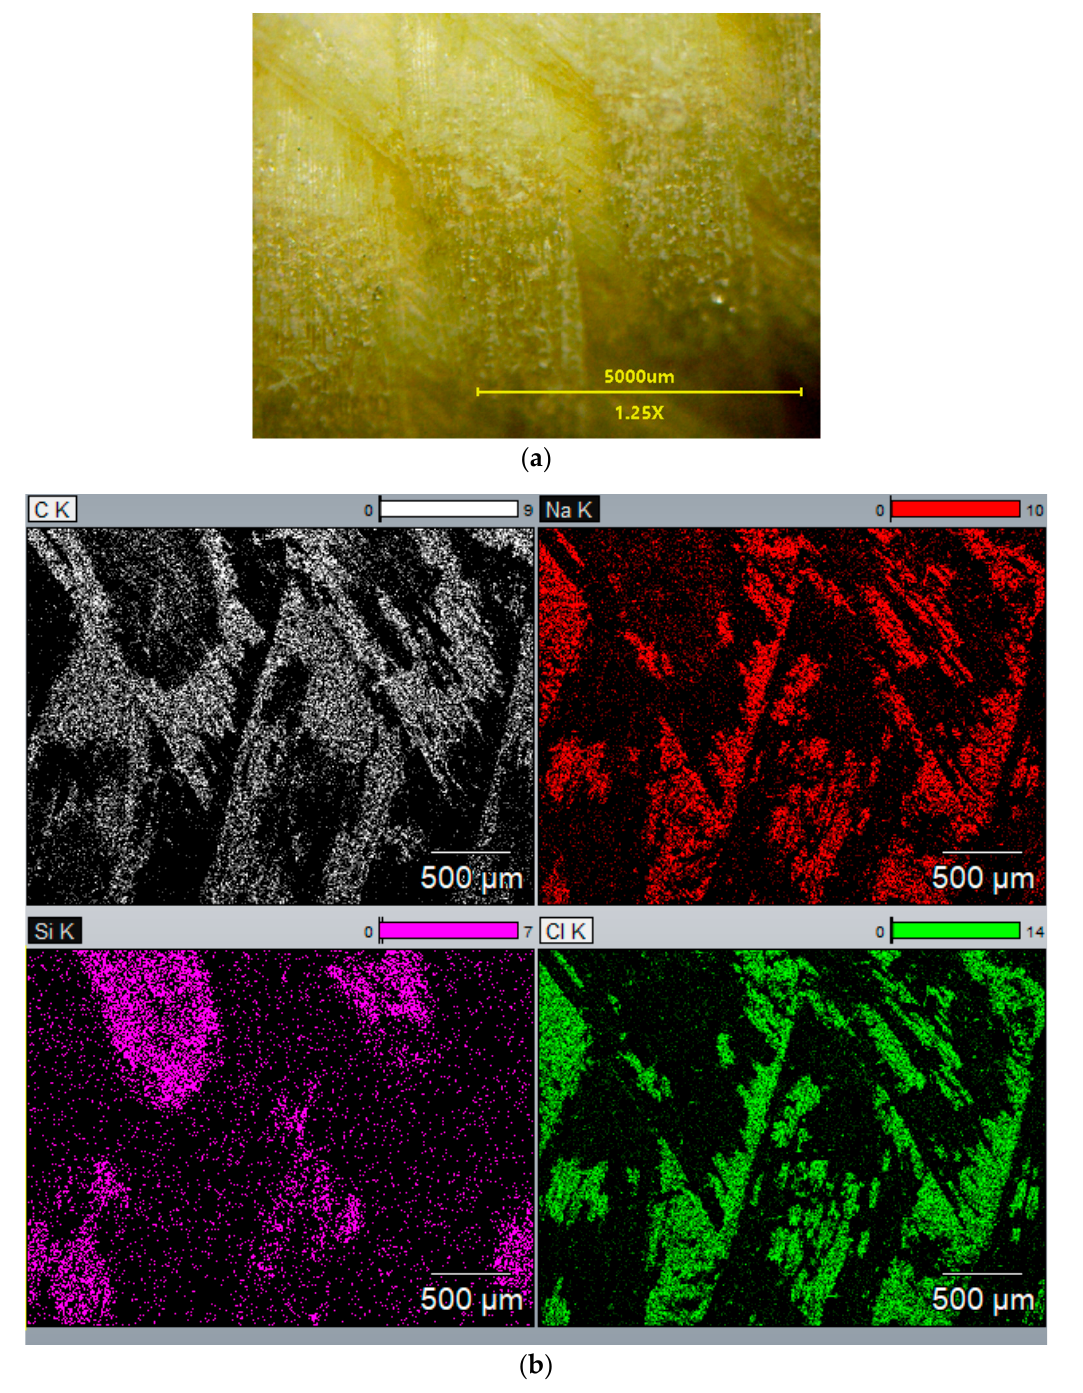
Figure 12. SEM images of net assembled on the V8N membrane. ( a ) NaCl crystals deposited on the net surface, ( b ) results of SEM-EDX analysis (mapping of elements).